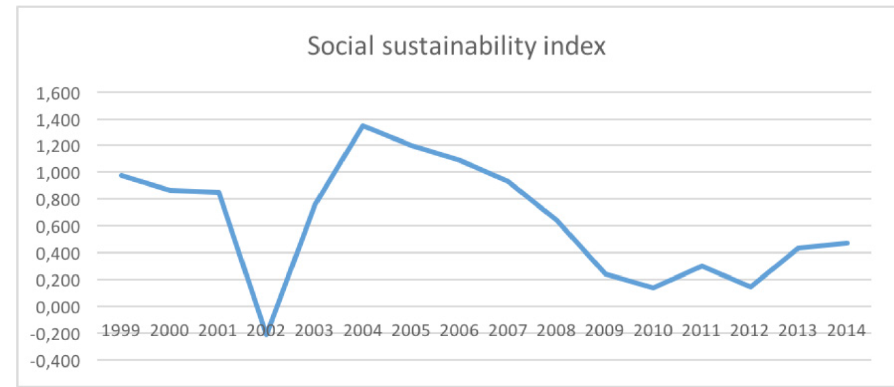
Figure 3. Evolution of the social sustainability index